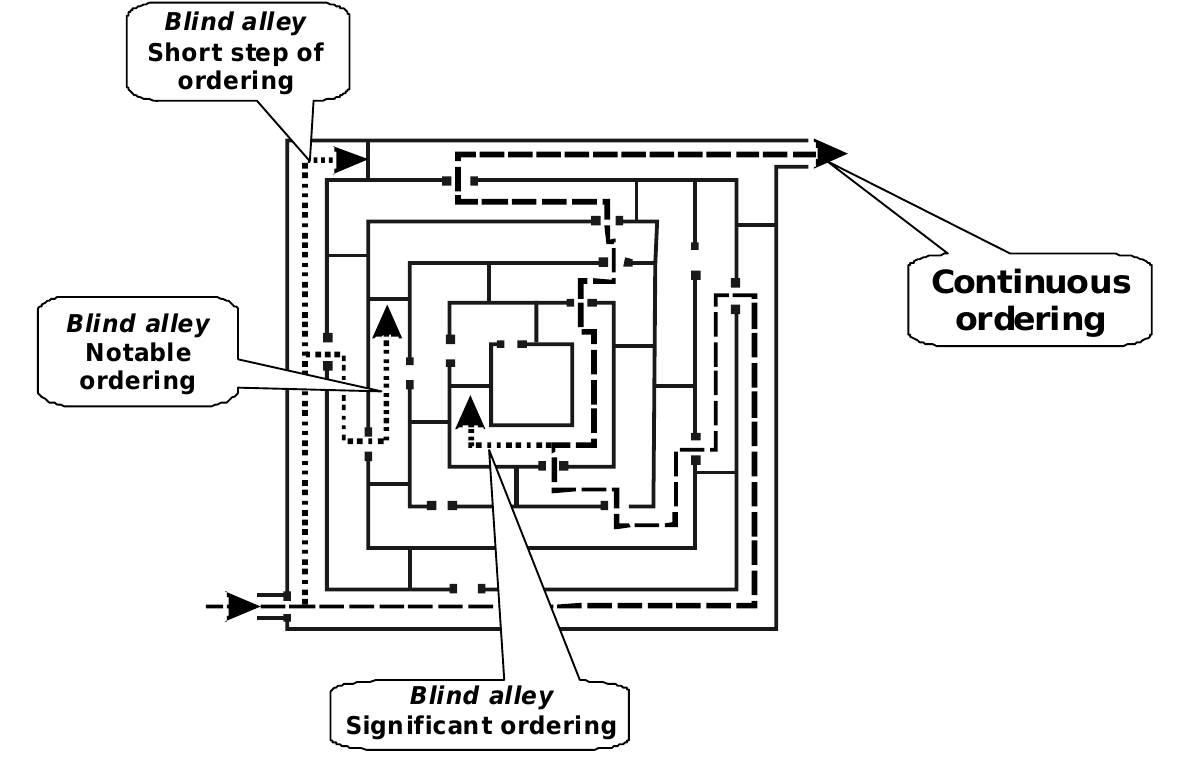
Figure 4. Straying in a labyrinth as an illustration of evolving